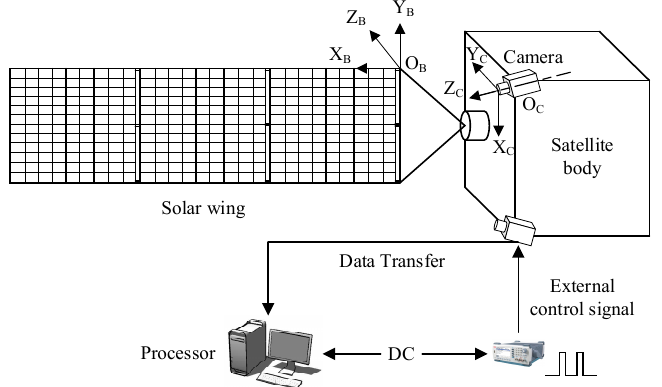
Figure 2. On-orbit measurement simulation test program diagram.